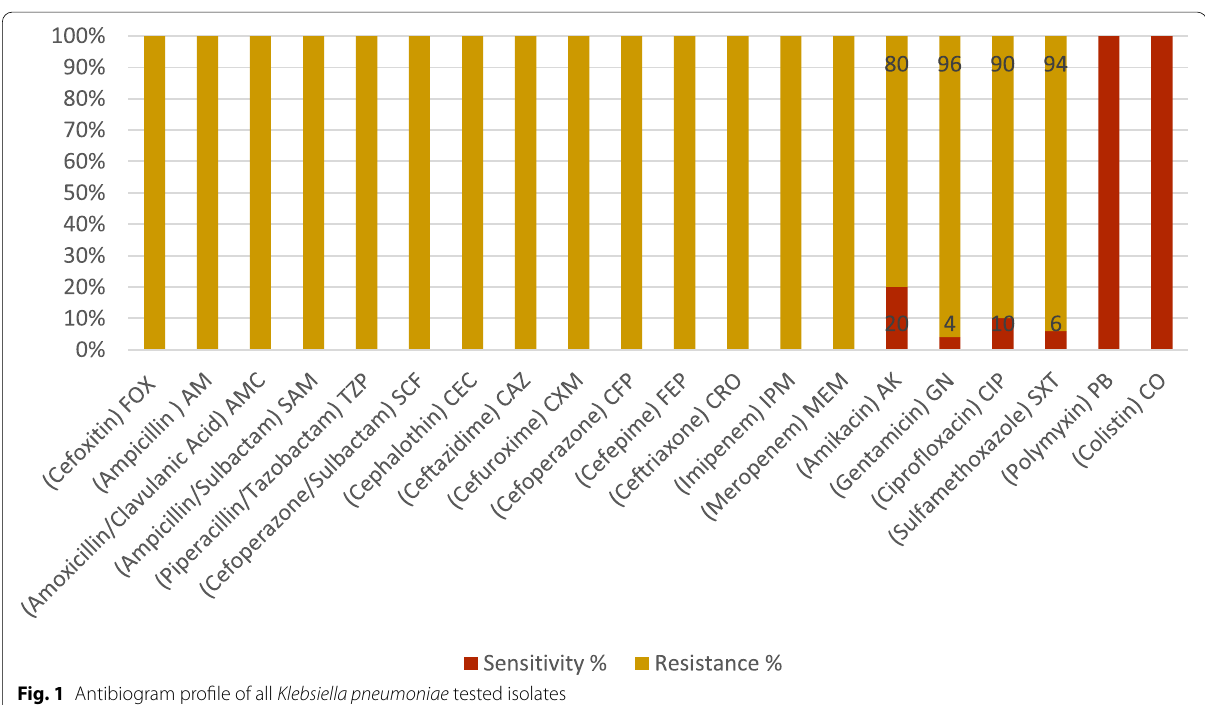
Fig. 1 Antibiogram profile of all Klebsiella pneumoniae tested isolates